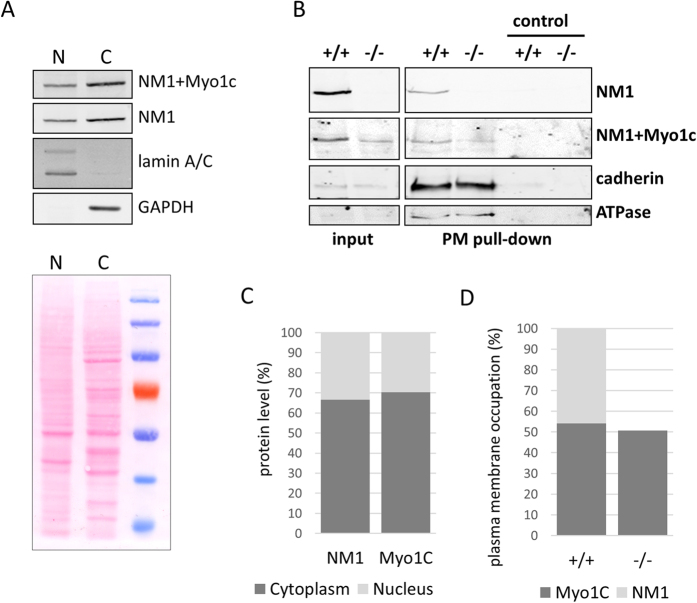
NM1 and Myo1c localize predominantly to the cytoplasm.(A) Hela cells were fractionated into the cytoplasm (C) and nuclei (N), and the same amounts of proteins from each fraction were resolved by SDS-PAGE as shown on ponceau stained gel. The purity of each fraction was assessed using lamin A/C and GAPDH as markers. (B) Plasma membrane fragments were resolved by SDS-PAGE. ATPase and cadherin were used as markers of the plasma membrane fraction purity and as a loading control. Empty beads were used as negative control. NM1 or both NM1+Myo1c were detected by corresponding antibodies using western blotting. (C) Densitometric analysis of the immunoblotting shown in (A) shows that there is predominant localization of NM1 and Myo1C in the cytoplasm in comparison to the nucleus. (D) Densitometric analysis of the immunoblotting shown in (B) suggests that there is the same amount of NM1 as Myo1c at the plasma membrane and that KO of NM1 does not cause translocation of Myo1c to/from the plasma membrane. In both analyses, NM1 and Myo1c are detected by different antibodies; therefore, the signal of these antibodies was normalized to the known amount of purified NM1-Flag present within the same gel (not shown) and used for quantification. The experiment was repeated three times with consistent results.